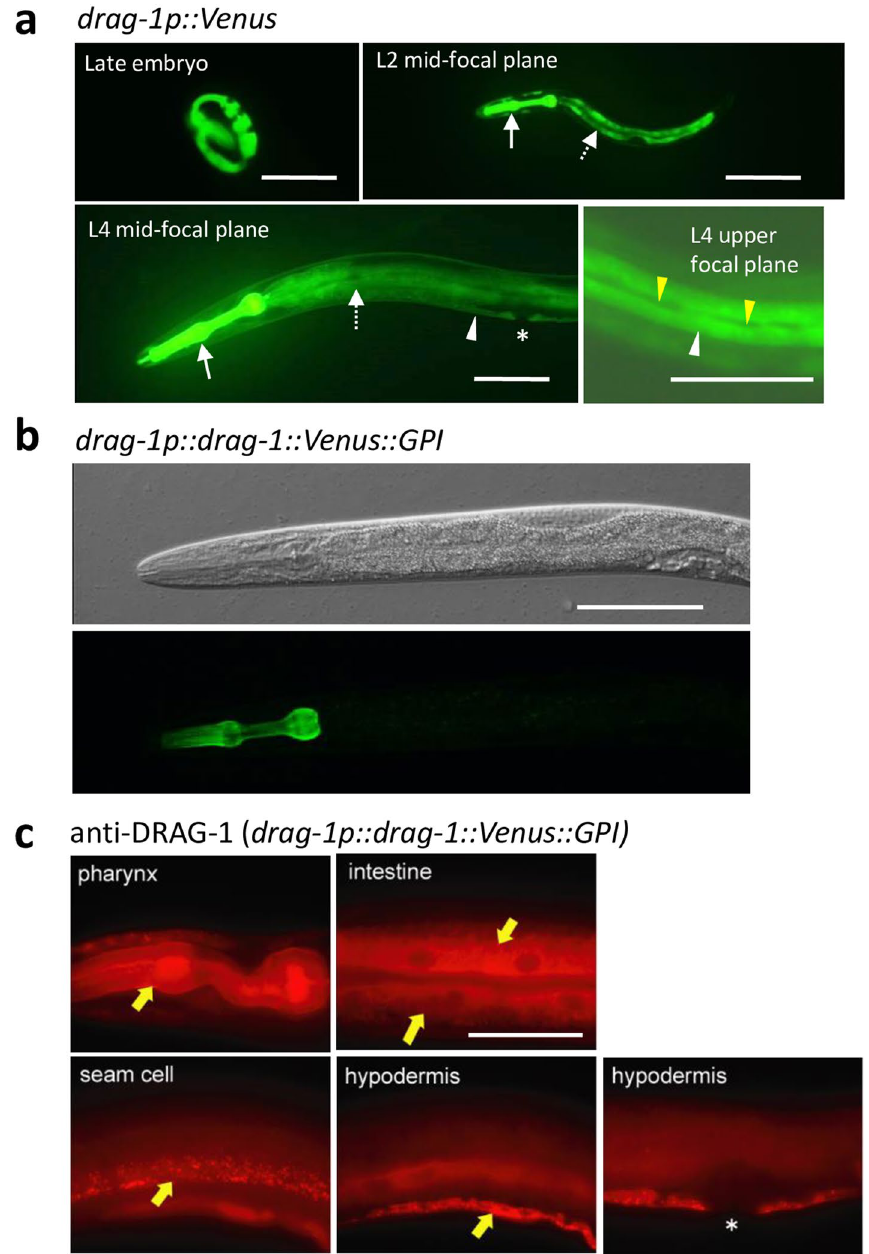
Figure 5. drag-1 expression. ( a ) drag-1p::Venus expression. Expression was detected from late embryos to the adult stage in the pharynx, intestine, and hypodermis. White arrows, dotted arrows and white arrowheads correspond to the pharynx, intestine and hypodermis, respectively. Yellow arrowheads and asterisk point to seam cells and developing vulval epithelium which do not express Venus, respectively. Scale bar: 100 μm. ( b ) Expression of drag-1p::drag-1::Venus::GPI. The drag-1p::drag-1::Venus::GPI plasmid was injected into unc-119(e2498) animals at 150 ng/μl with 30 ng/μl of pBSII KS(–) and 20 ng/μl pDP#MM016B. DIC (upper) and fluorescence (lower) images of an L4 stage animal are shown. Venus expression was detected only in the pharynx. Anterior is to the left. Scale bar: 100 μm. ( c ) Immunostaining using anti-DRAG-1. L4 to young-adult animals expressing drag-1p::drag-1::Venus::GPI were fixed and stained with anti-DRAG-1. DRAG-1 expression was detected in the pharynx, intestine, hypodermal seam cells, and ventral hypodermal cells (arrows) except the vulval hypodermis (asterisk). Scale bar: 50